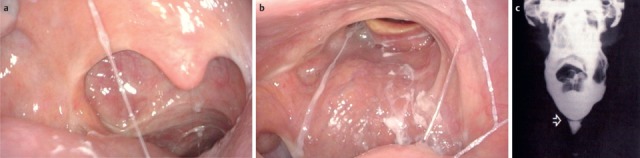
a – 87-year-old patient with significant oropharyngeal dysphagia after extended partial resection of the right oropharynx and right-sided neck dissection and radiochemotherapy (transoral endoscopy); b – very viscous saliva, scarred right-sided velum; the scars extend over the posterior oropharyngeal wall to the contralateral side, additionally there is a transportation disorder of the tongue (transnasal endoscopy); c – tissue formations (arrow) in the pharynx or esophagus cause globus sensation and/or dysphagia complaints (radiography, different patient).